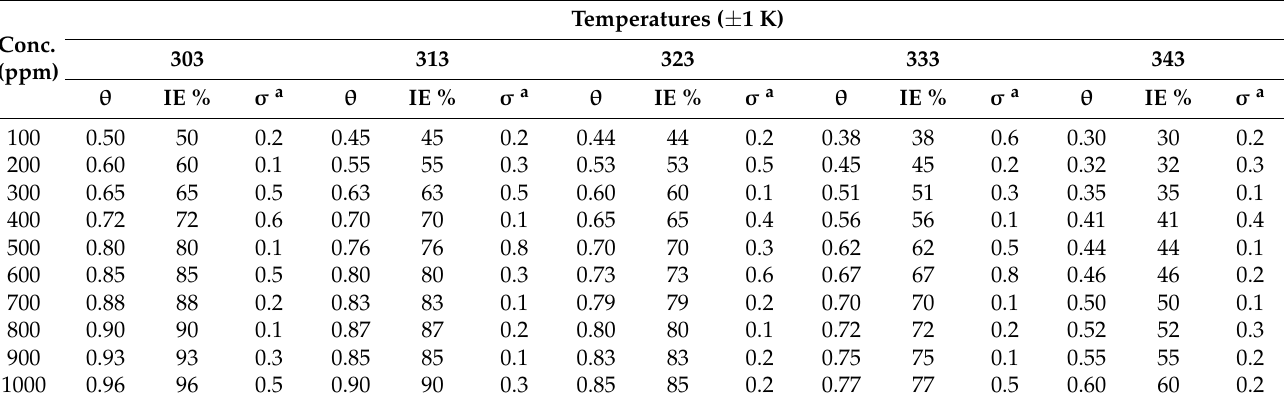
Table 4. Inhibition efficiency (IE %) for different concentrations (Conc.) of methanolic fruit extract of P. ginseng for corrosion of copper in 1 M HCl at different temperatures (303–343 ± 1 K). Conc.